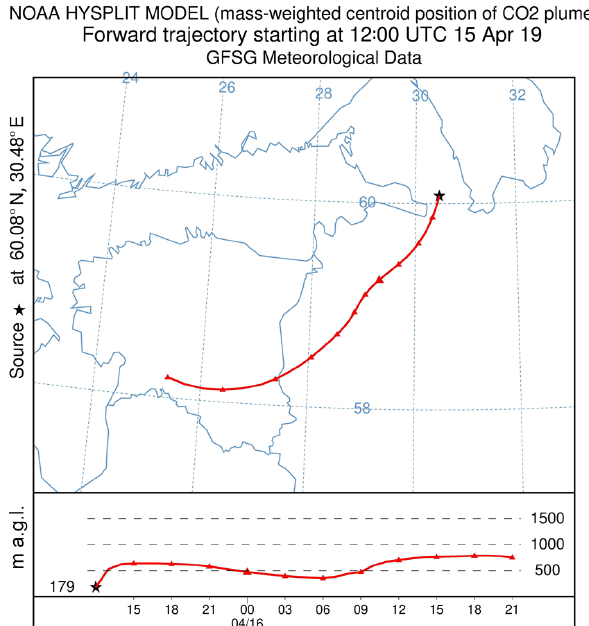
Figure C1. Evolution of the mass-weighted centroid position of the CO 2 plume taken as an example (see